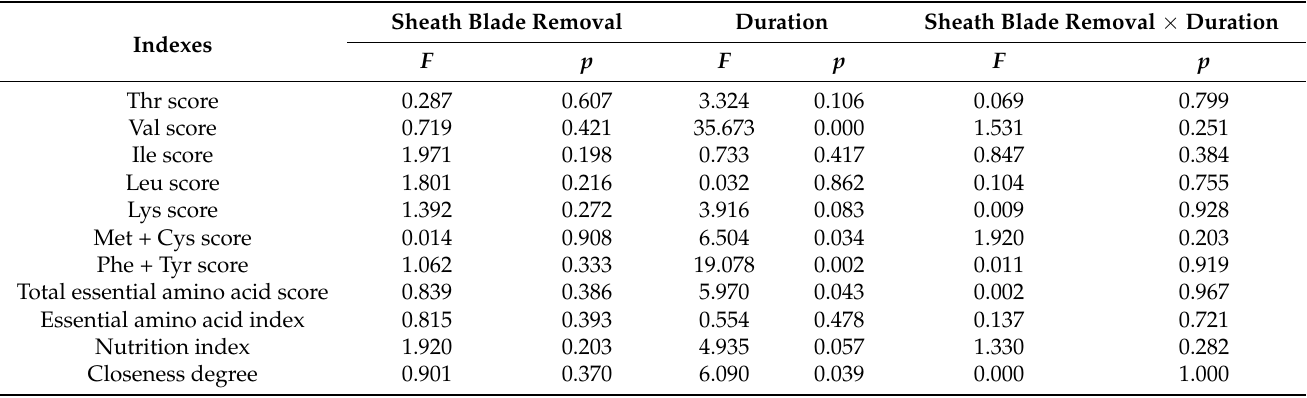
Table 3. Statistical two-way ANOVA results of Ph. violascens sheath blade removal on shoot nutritional